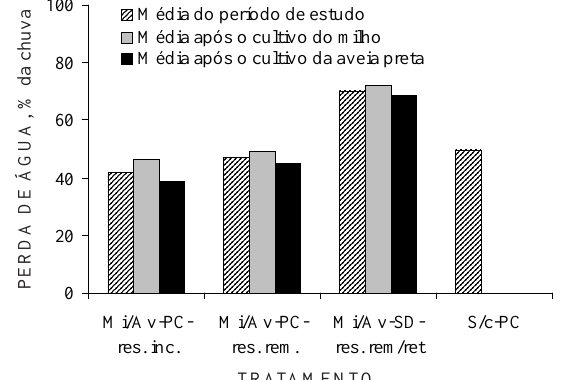
Figura 3. Valores médios da perda total de água do período de estudo, após o cultivo do milho e após o cultivo da aveia preta ( 1 Milho/aveia preta, preparo convencional, resíduo cultural incorporado; 2 milho/aveia preta, preparo convencional, resíduo cultural removido; 3 milho/aveia preta, semeadura direta, resíduo cultural removido e retornado; 4 sem cultivo, preparo